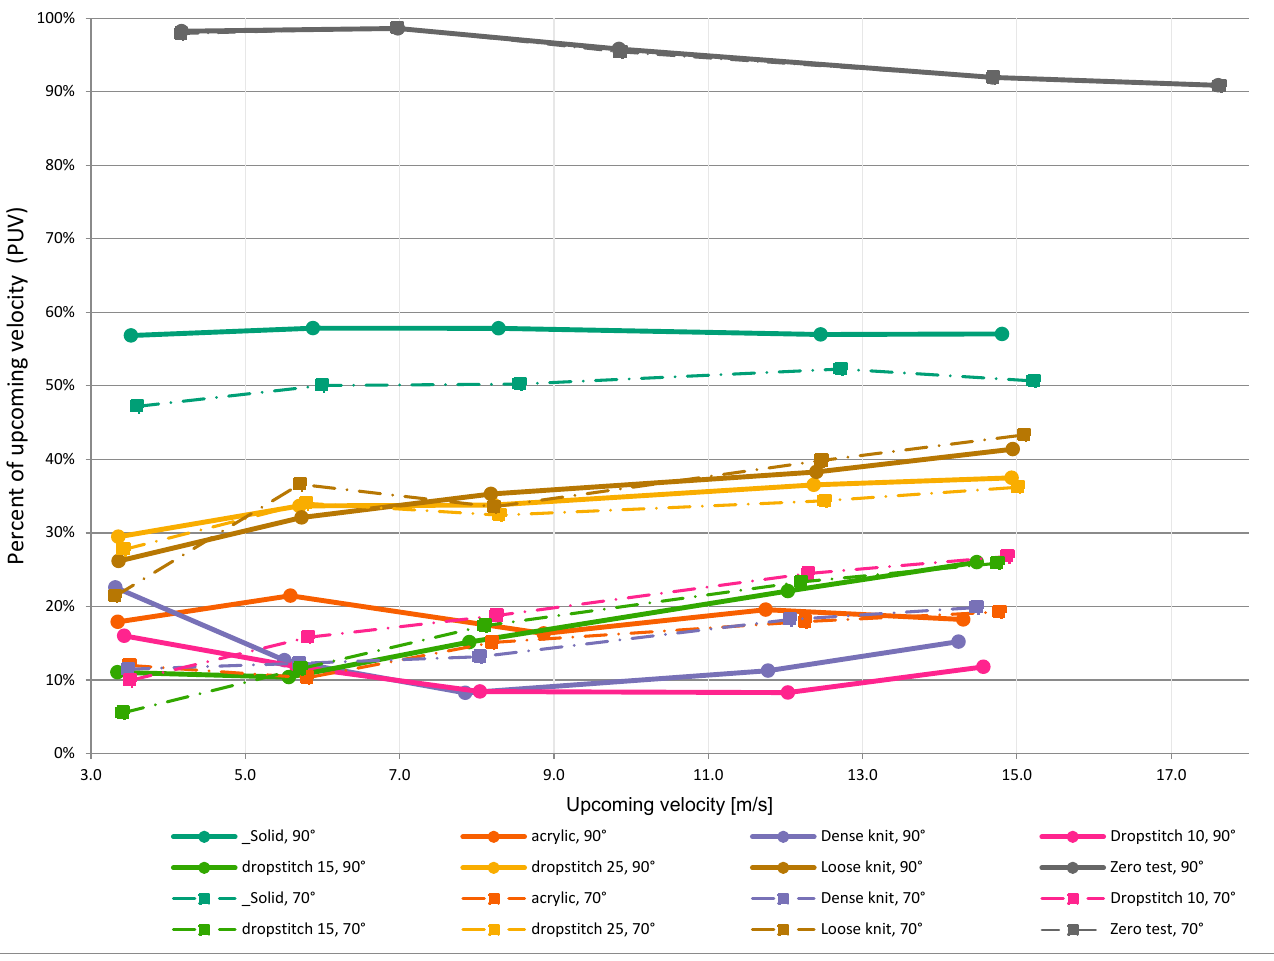
Figure 10. Percent of upcoming velocity (PUV) for the screens positioned at an angle of 70° and 90° to the wind.